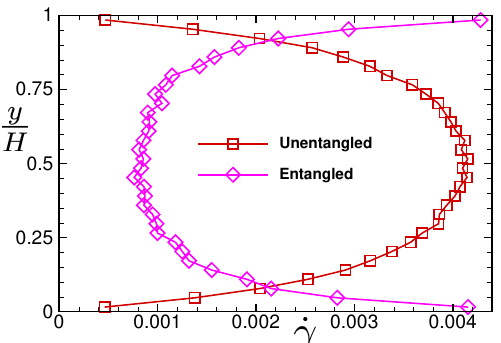
Figure 7. Comparison of the spatial profiles of local shear rate ˙ γ ( y ) between the present entangled polymeric liquid and the unentangled polymeric liquid studied in Ref. [22]. For the entangled one, the result for the drive force p w = 0.05 is plotted, while for the unentangled one, the result obtained for p w = 0.08, T w = 0.2, ρ 0 = 1.0 and H = 2500 is plotted. Please note that the vertical axis shows the normalized distance from the wall at rest to the wall in motion.